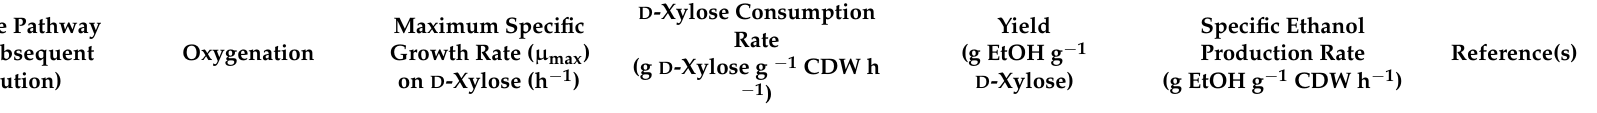
Table 1. Batch cultivation performances for some of the best reported S. cerevisiae strains engineered for D -xylose utilization, by rational engineering and laboratory evolution. Under anaerobic conditions, the best reported strains (XR/XDH and XI strategies) reach ~80% of the maximum ethanol yield (0.51 g EtOH g − 1 D -xylose). Productivity, however, remains low compared to values for D -glucose where production rate of ethanol and consumption rate of D -glucose can reach 1.2–2.5 g EtOH g − 1 CDW h − 1 and 3 g D -glucose g − 1 CDW h − 1 , respectively [40]. * A xylonate formation rate from D -xylose of 0.11 g L − 1 h − 1 (1:1 stoichiometry) was reported but no data on cell dry weight [16]. Note that the table does not reflect on the capacity of these strains for D -glucose/ D -xylose co-utilization. XI: xylose isomerase; XR/XDH: xylose reductase/xylitol dehydrogenase; CDW: cell dry weight; N/A: not